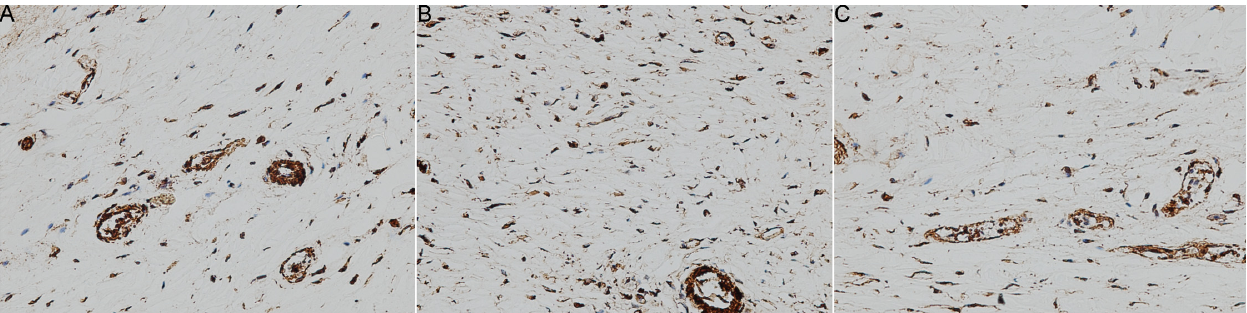
Figure 3. Representative immunohistochemical images (200×) of the posterior joint capsule in ( A ) the non-operated control (CON) group; ( B ) the ORC group and ( C ) the CNT group. Cell nuclei associated with α -SMA were counted as myofibroblasts.